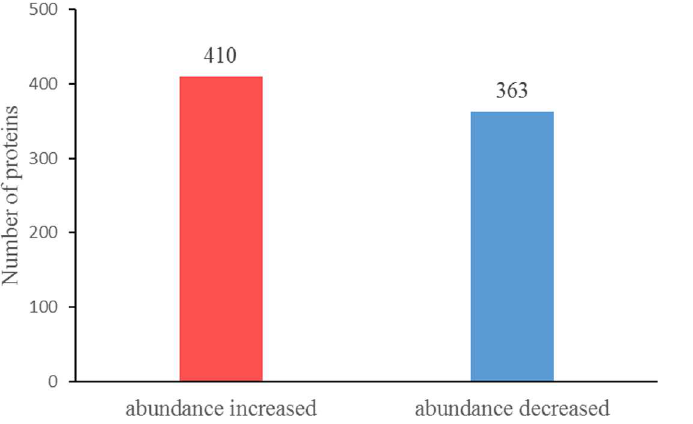
Fig 3. The differentially abundant proteins in PA2 vs . PA4.